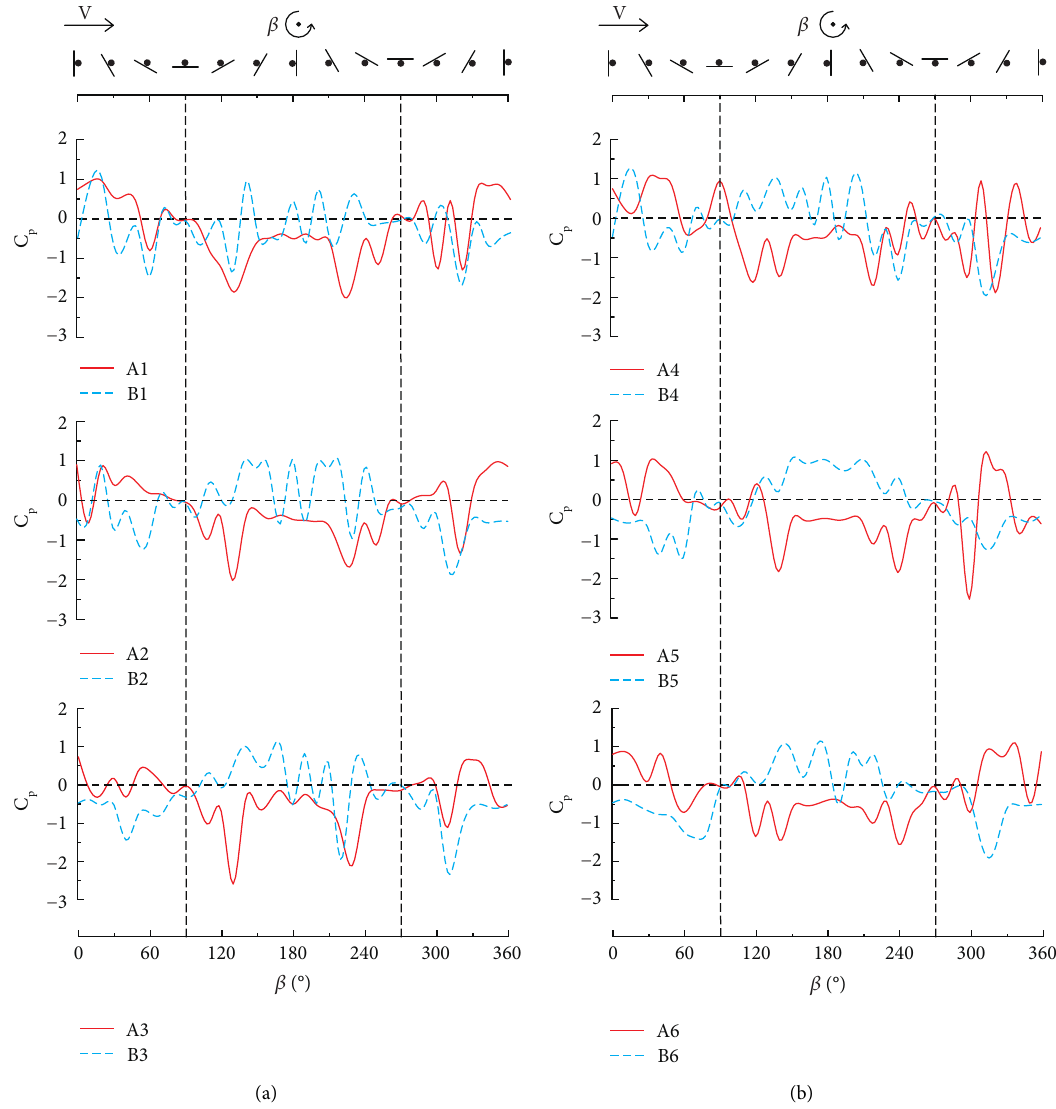
Figure 10: Pressure coefficients of the surface monitoring points with respect to azimuth angle when the solid plate antenna is stationary, β � 0–360 ° , and Δ � 10 ° . (a) Monitoring points 1, 2, and 3; (b) monitoring points 4, 5, and 6 (A represents the front of the antenna and B represents the back of the